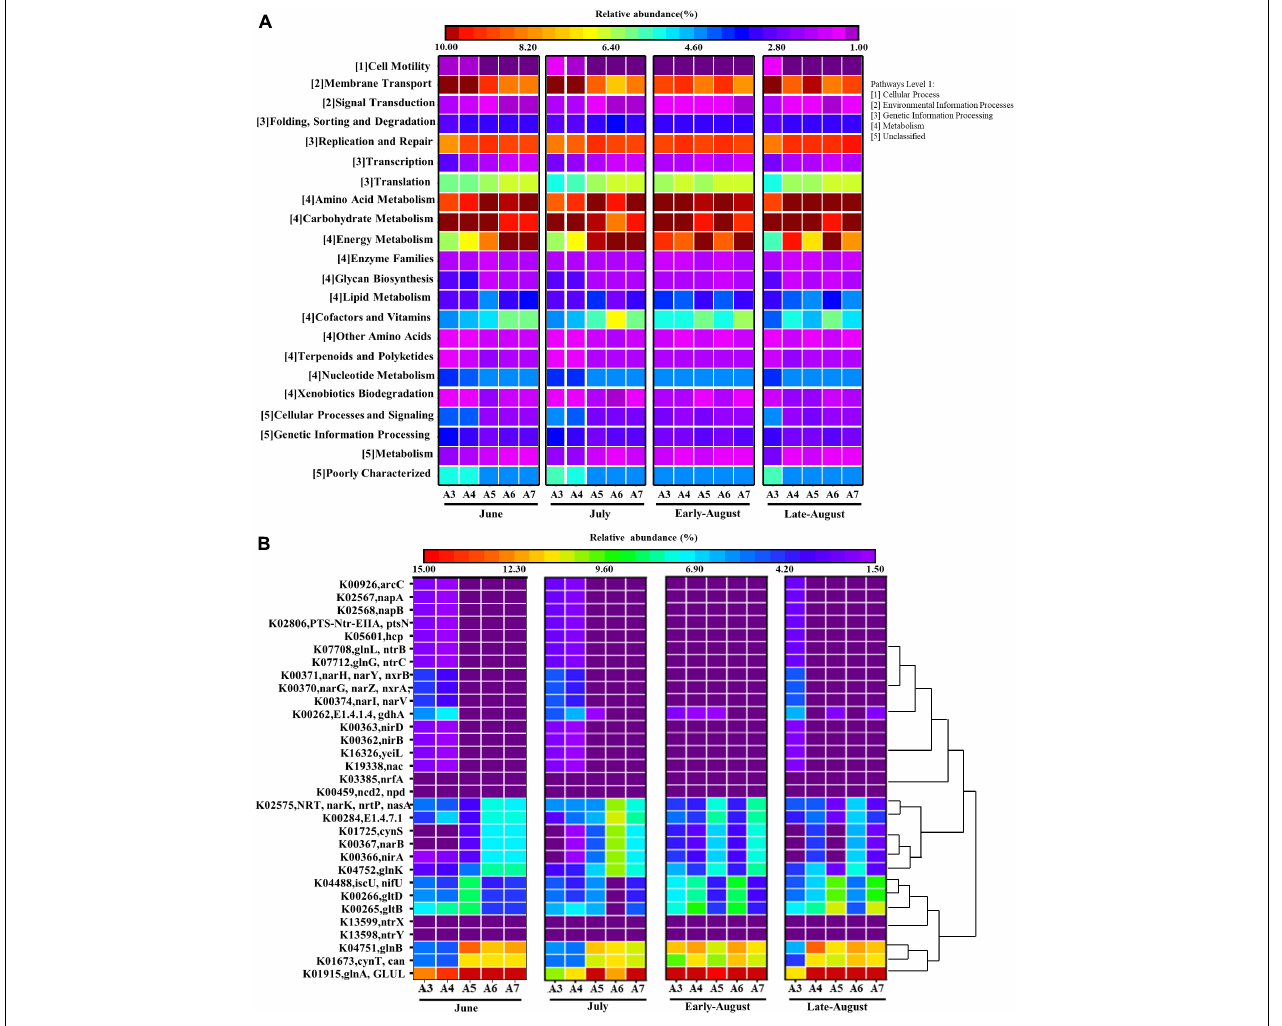
FIGURE 4 | Heatmap profiles showing the functional categories (KEGG level 2) of bacteria communities predicted by PICRUSt analysis (A) and nitrogen metabolism-related KO based on predicted gene copy (B) in each sampling time and site. (Rows represent the 22 KEGG orthology (KO) functions, columns represent the twenty samples, and the color intensity in the heatmap represents the relative abundance (%) of the functional genes. Pathways are displayed on the y axis, the number (1–5) in front of pathway names correspond to the number (1–5) of Pathways Level 1 shown on the